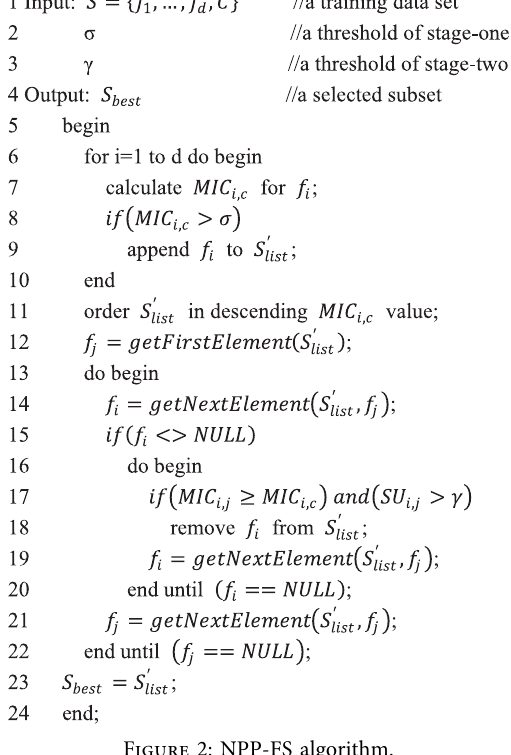
Figure 2: NPP-FS